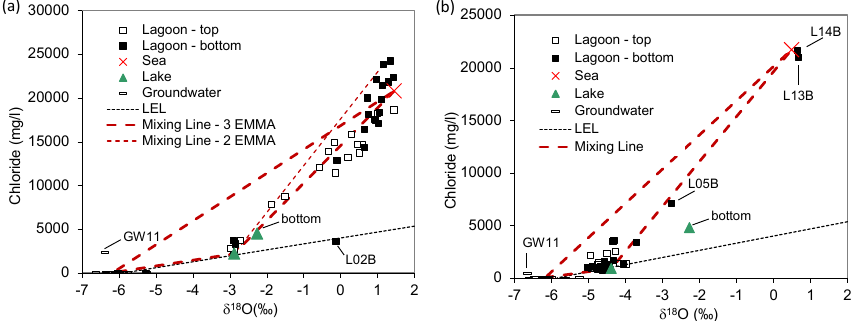
Figure 5. Chloride concentrations and δ 18 O ratios for (a) dry season and (b) wet season sampling campaign; the dashed lines connect the three (bold) or two (light) endmembers used for the mixing analysis.